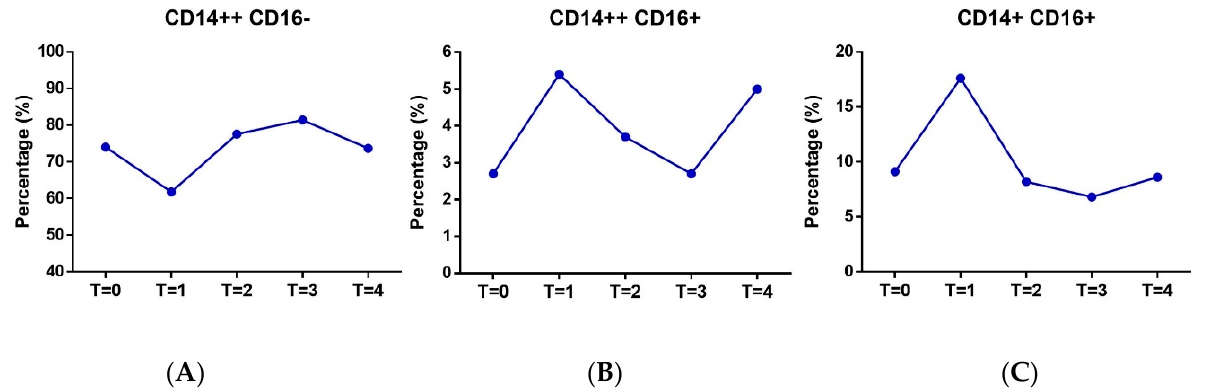
Figure 3. Analysis of mDC (red line) and plasmacytoid DC (pDC) (blue line) subtypes at different monitoring points (T0 to T4) according to the specific phenotypic markers Lin − HLADR+ CD11+/ − CD123 − /+. * Shows a strong maturation response observed for mDCs that mirrored by a decrease in pDCs.